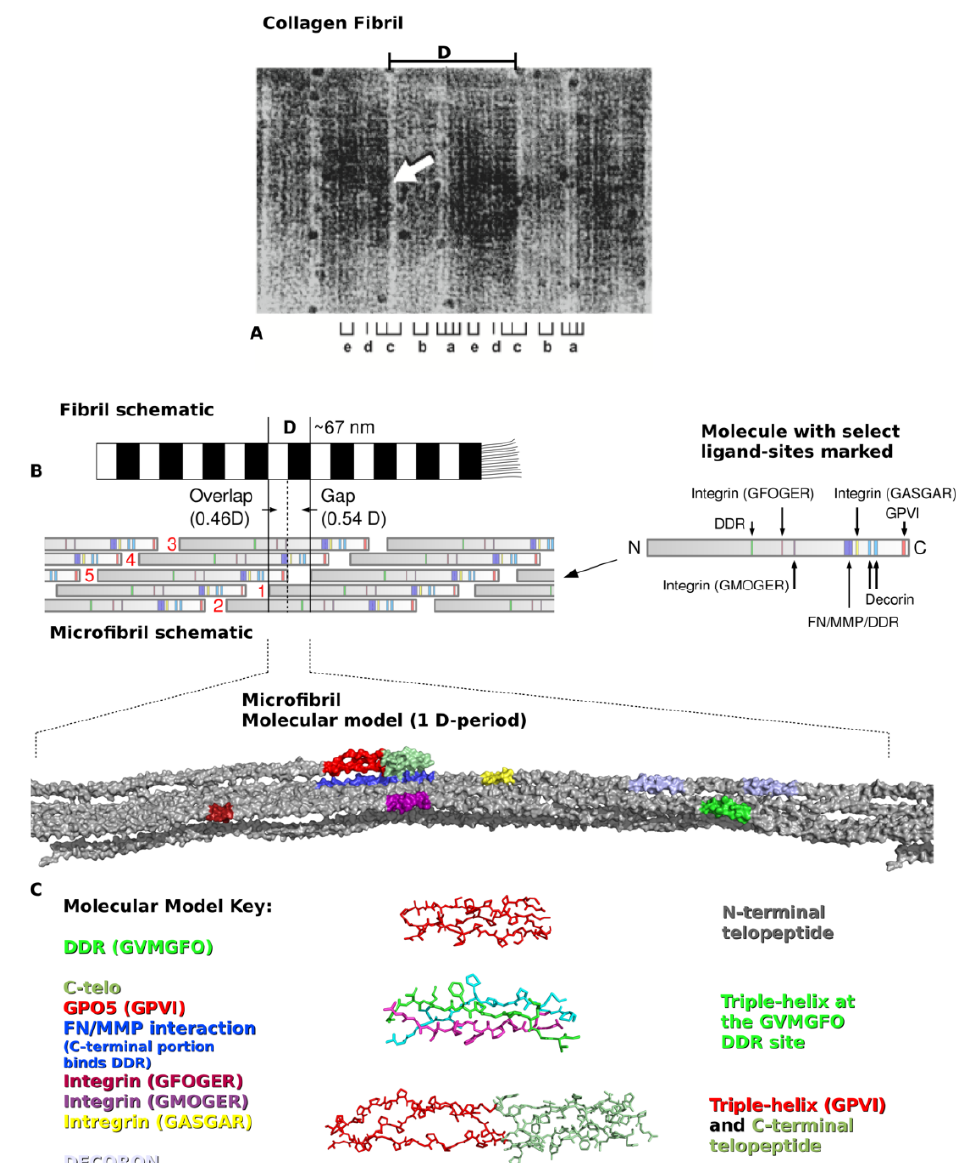
Figure 1. Type I collagen assembly and structure. ( A ). Segment of Type I collagen fibril visualized by transmission electron microscopy. One molecular repeat or D-period (D) is indicated. The positive stain microscopy bands, a–e, are as indicated below the image; arrow indicates left border of overlap zone. This fibril preparation was used to localize heparin-binding sites; thus, heparin-gold particles appear as dark circles bound to the fibril. Originally published in San Antonio et al., 1994, J. Cell Biol ., 125 , 1179–1188. ( B ). Fibril schematic depicted as negatively-stained TEM preparation where gap regions are dark and overlap regions light. Microfibril schematic shows the Hodge-Petruska scheme [20] of packing where collagen molecules (numbered 1–5 for molecular (M) segments as in M1, M2, etc.) are staggered so that every five M segment does not traverse the entire D-period. Select collagen functional domains (right) are marked along the length of the collagen molecule. ( C ). A single D period of a single microfibril is shown beneath the microfibril schematic. The C-terminal telopeptide (marked in green on the top of the microfibril) and the rest of monomer 5 is orientated towards the outside of the fibril. The side view is from an observers’ perspective from a neighboring microfibril. Note the molecular segments are relatively straight in the overlap zone but re-organize towards the end of the gap zone especially in the region of the supertwist in the vicinity of the gap zone’s discoidin domain receptor 2 (DDR2) binding site. Figure segments reprinted with permission from [21].